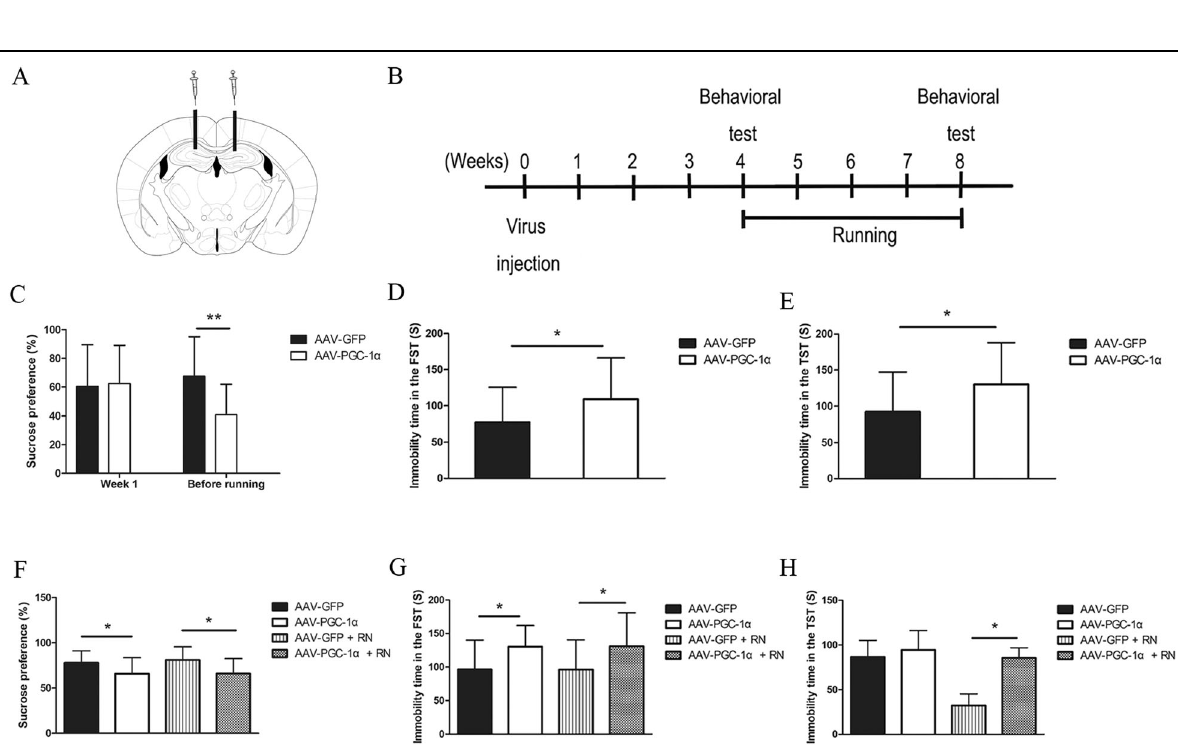
Fig. 2 Comparisons of the behavioral test results of mice in different groups. A Schematic showing the positions of adeno-associated virus injection in hippocampus of mice. B Schematic showing behavior experiment timeline. The behavioral tests include SPT, FST and TST. C – E The sucrose preference and immobility time in the FST and TST (mean ± SD) of mice in AAV-GFP group ( n = 30) and the AAV-PGC-1 α group ( n = 31) before running exercise. * indicates p < 0.05, and ** indicates p < 0.001. F – H The sucrose preference and immobility time in the FST and TST (mean ± SD) of mice in the AAV-GFP group ( n = 15) and AAV-PGC-1 α group ( n = 15), AAV-GFP + RN group ( n = 15) and AAV-PGC-1 α + RN group ( n = 16) after running exercise. * indicates p <